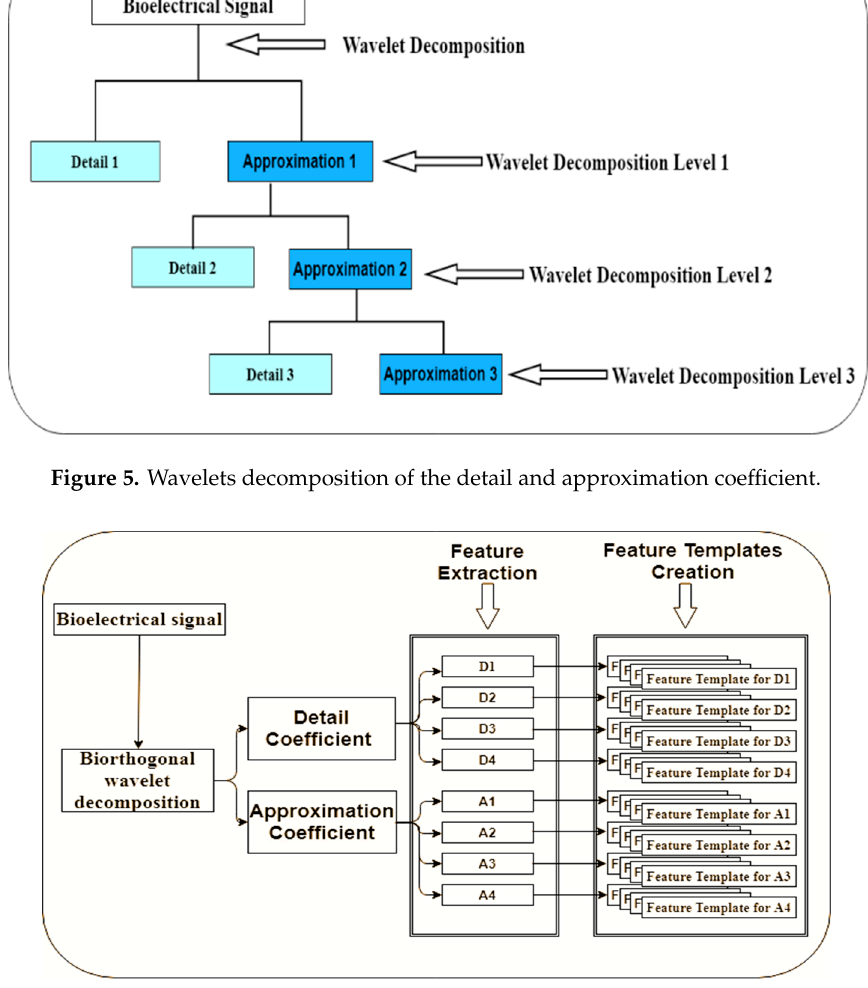
Figure 6. Wavelets schematic illustration of the feature extraction process.